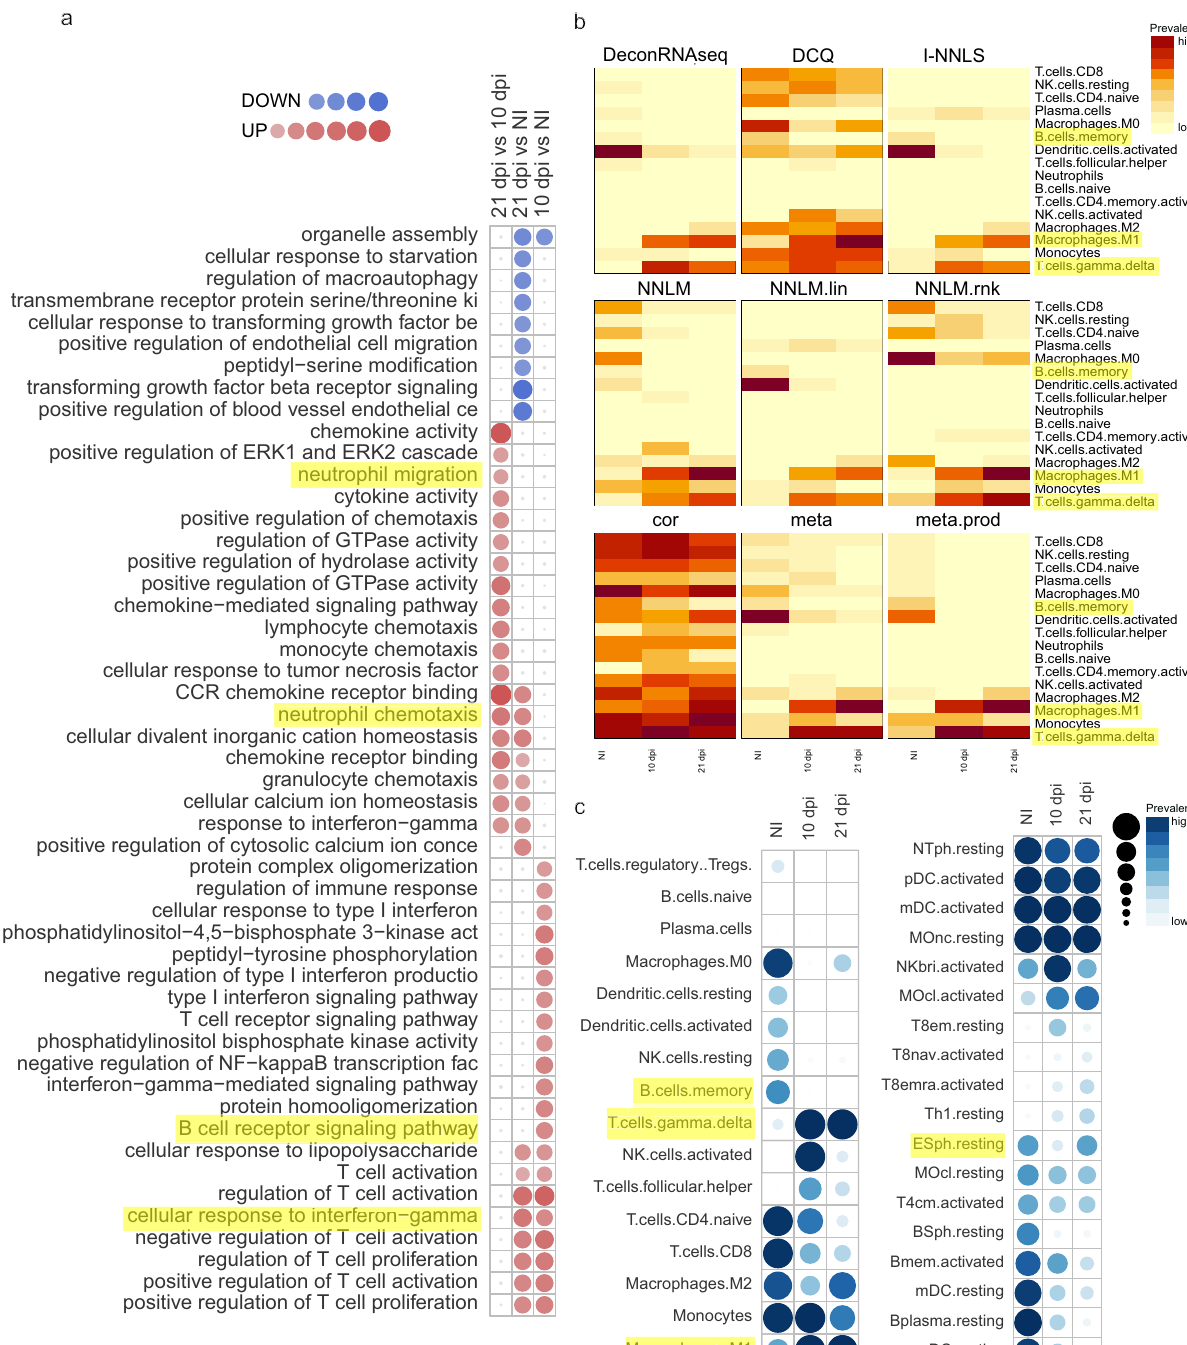
NNLM.rnk,cor,meta,meta.prod)intheOmicsPlaygroundsoftware. c Overviewdot